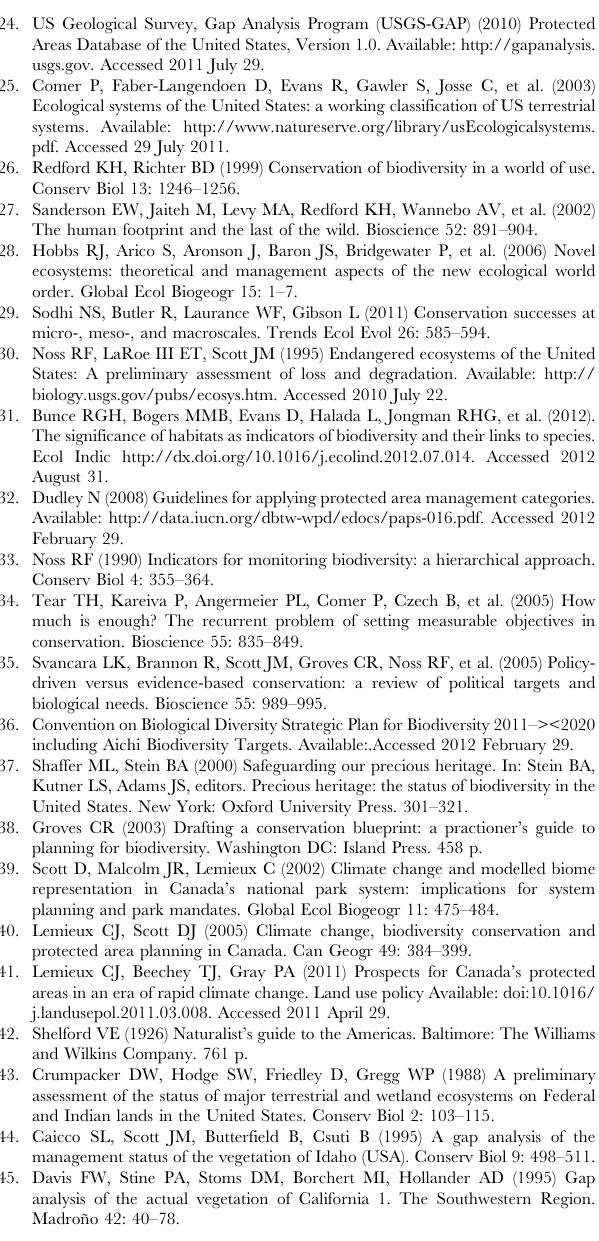
Table S1 Area (ha) and percent area of ecological systems by protection status nested into Level I and II land cover groups [ 23,24 ] . All 5 Level I groups, 37 Level II groups, and 518 ecological systems are listed. See Table 1 for protection status descriptions. Only non-modified, non-aquatic ecological systems are included (n=